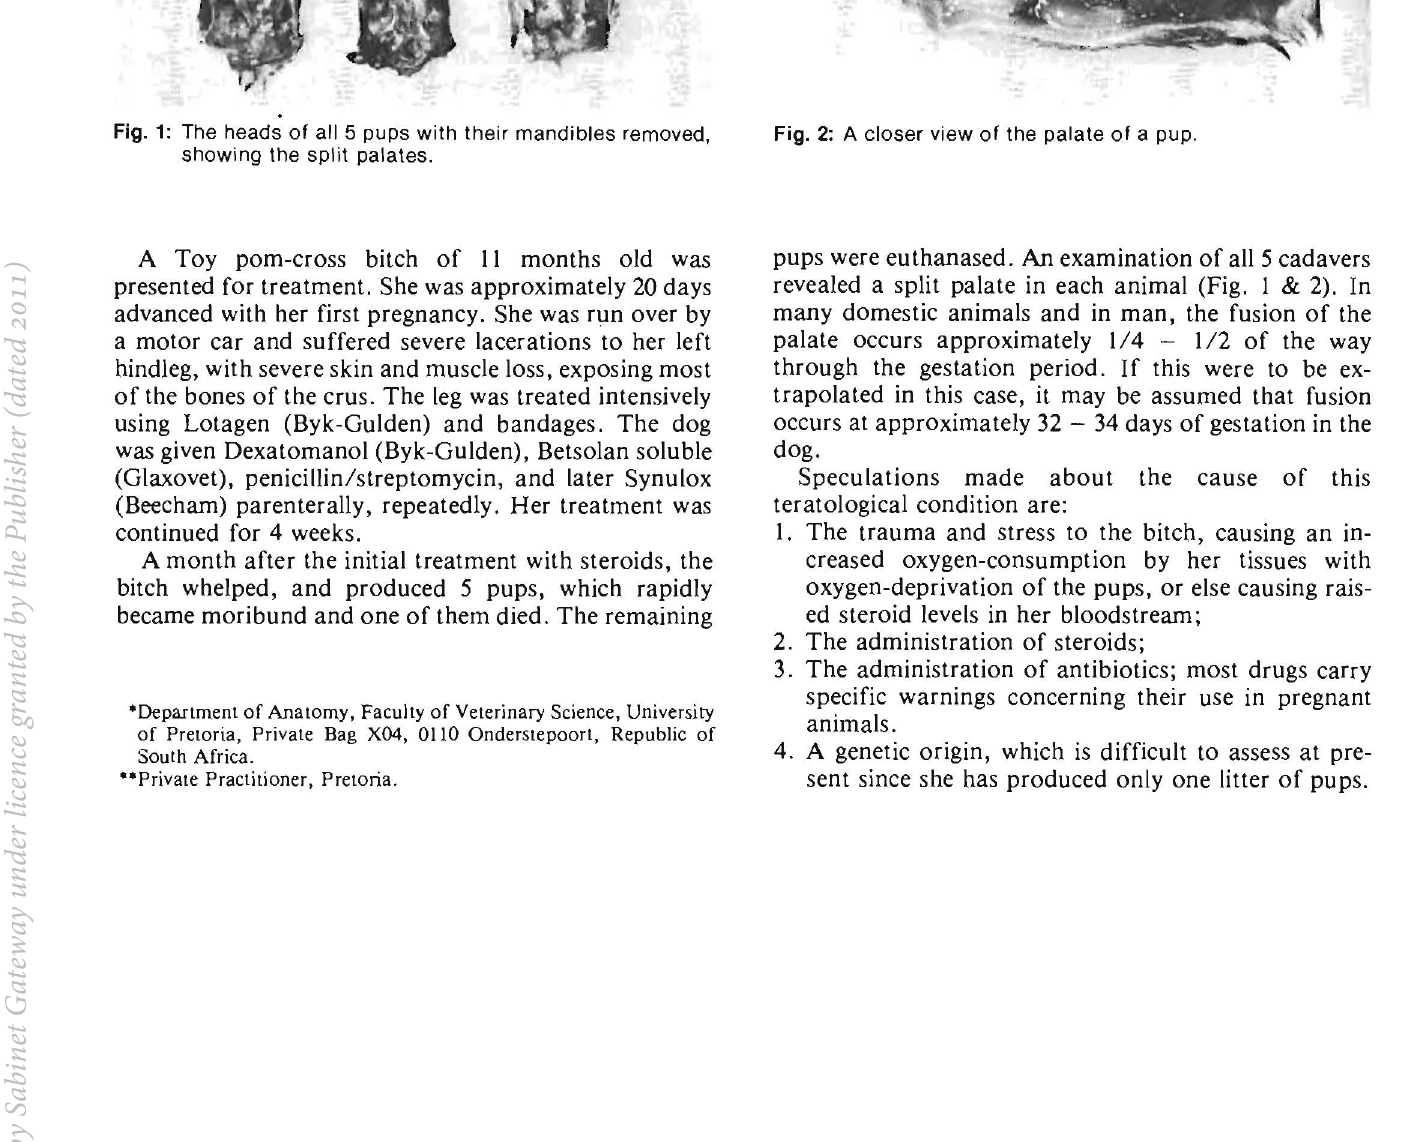
Fig. 2: A closer view of the palate of a pup.